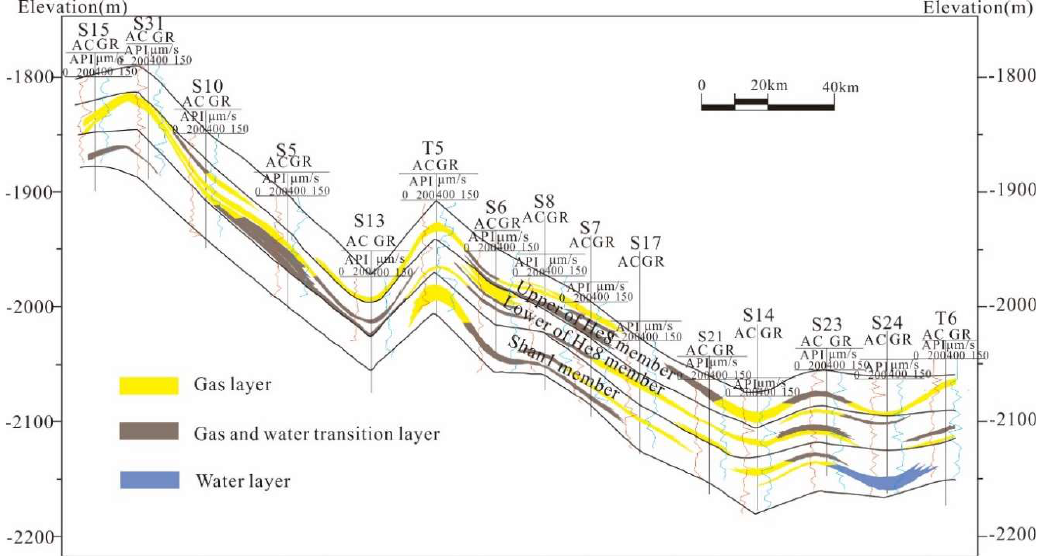
Figure 7. Gas–water distribution in S15-T6 section (section location in Figure 1).